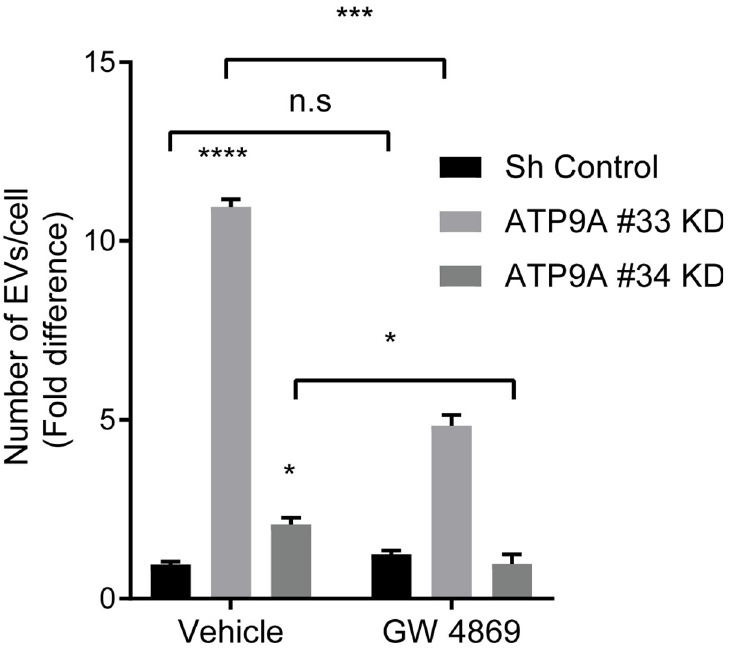
Fig 4. Ceramide dependent release of EVs in ATP9A knock-down cells. ATP9A knock-down and sh-control cells were incubated for 66 hours with GW4869 (10 μ M) or vehicle (1% DMSO). The mean of excreted EVs/cell of a representative of 3 independent experiments all performed in triplo (n = 9) ± SD is shown. Statistical significance was tested by two-way ANOVA with Tukey’s correction for multiple testing: ��� p < 0.0005 and n.s p � 0.05.+ represents the nonsignificant